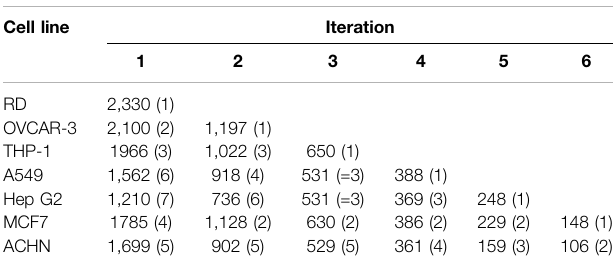
TABLE 4 | Using the DARTable Genome to Identify the Relevant Cell lines. Seven celllineswererankedbythenumberofHDGgenestheyexpressthatmeetthe selectioncriterion.Thetopscoringcelllinewasthenselectedforthepanelandthe remainingcelllineswerethenre-ranked,basedonhowmanyHDGgenesthatmet the selection criteria were not already covered by the cell line(s) already selected forthe panel. Foreach celllinein each iteration, weshowthenumber ofadditional HDG with above per average gene expression that celllinewould add and the cell lines ranking in parentheses. Cell